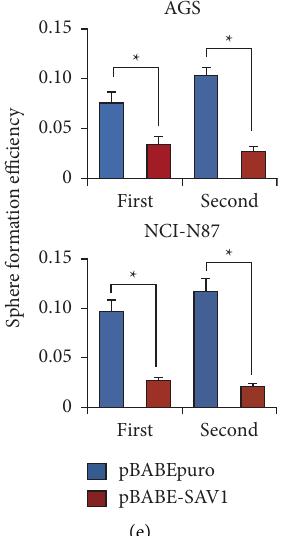
Figure 2: SAV1 suppresses GC cell proliferation in vitro . (a) Transfection efciency of SAV1 overexpression vectors and shRNA in GC cell lines determined via western blotting. AGS and NCI-N87 cells were transfected with pSAV1 or control vectors. HTB103 cells were transfected with shSAV1-1, shSAV1-2, or control shRNAs. AGS and NCI-N87 cells were infected with retroviruses containing SAV1 (pBABE-SAV1) and empty retroviral expression vector (pBABE-puro). (b, c) Te colony formation assay was performed on AGS and HTB103 cells in 24-well plates, and the numbers of colonies were counted after 14days. (d, e) Te spheroid colony formation assay was performed on AGS and NCI-N87 cells. SAV1 overexpression decreased the number and size of the frst and second generations of spheroids. SAV1, Salvador homologue 1; GC, gastric cancer; shRNA, short hairpin RNA.